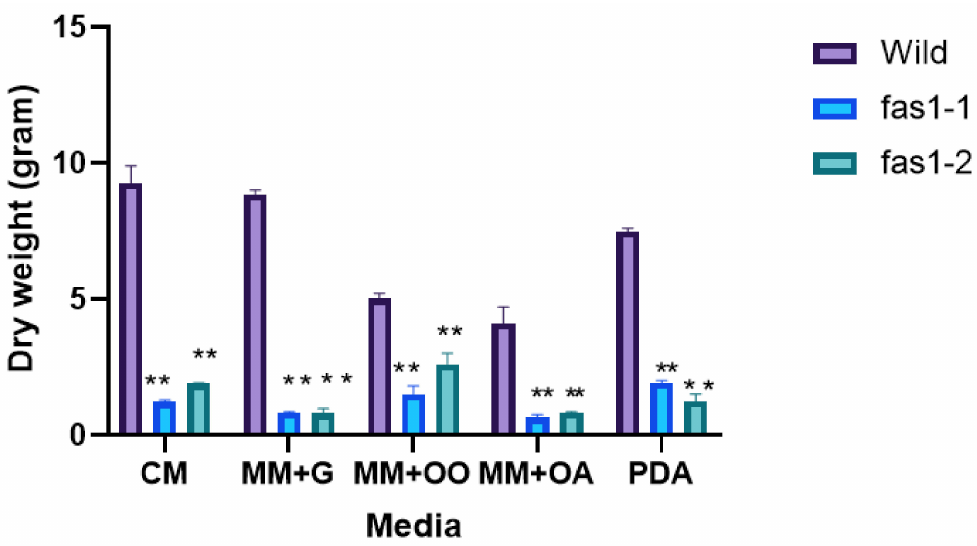
Figure 6. Dry weight assay of wildtype strain S6 compared to mutant. Dry weight of wildtype mycelium, fas1-1 and fas1-2 on five di ff erent carbon sources was taken 10 days post-growth at 26 ◦ C. Error bars represent standard deviation from three biological replicates of this experiment. Double asterisks represent significant di ff erence (** p ≤